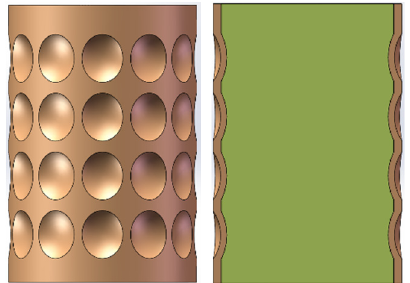
Figure 1. Structural design of integral circumferential MEFP warhead.